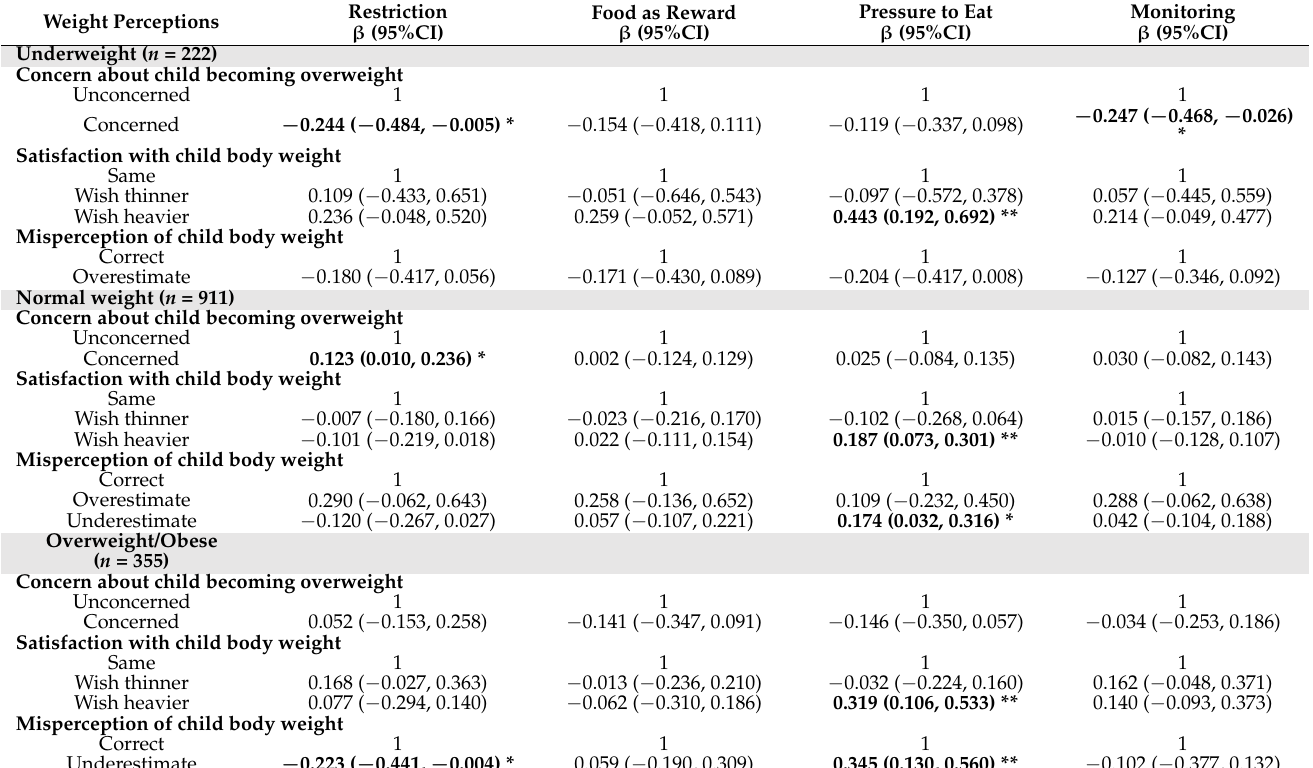
Table 4. Linear regression relationships between parental weight perceptions and caregiver feeding practices among different ZBMI weight status of children.